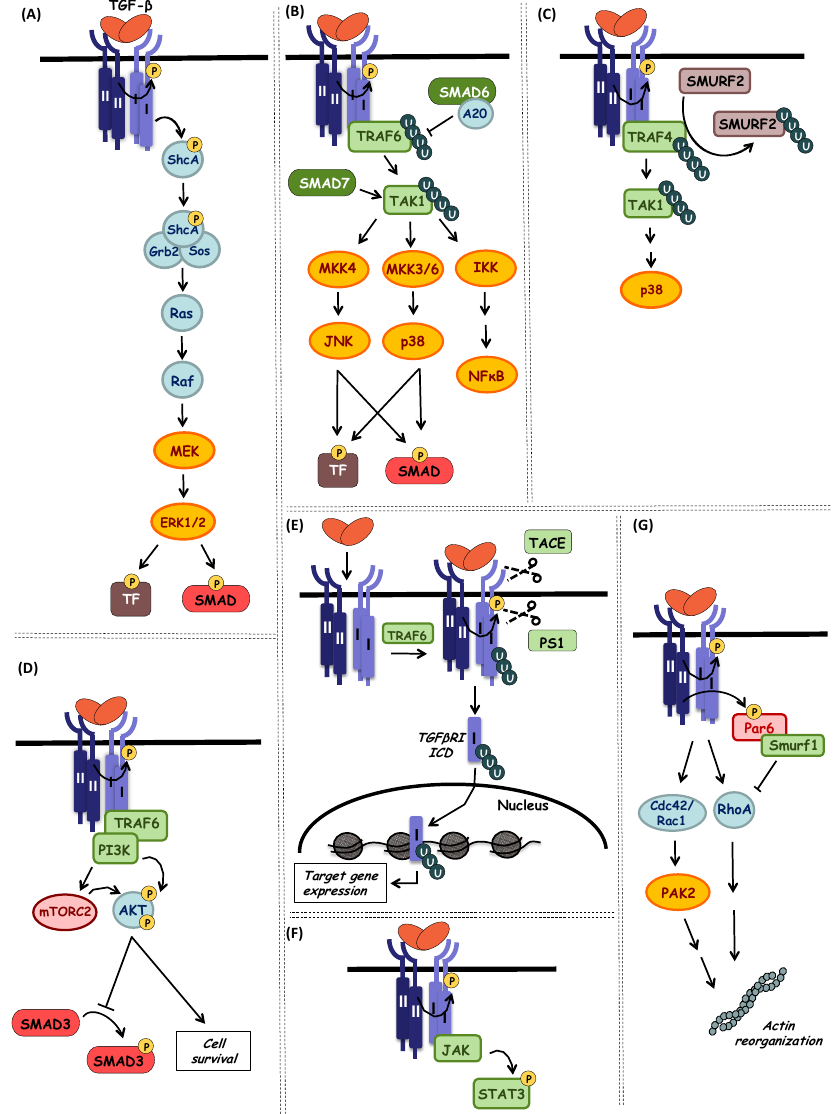
Figure 6. The TGF-β non-SMAD signaling pathways. ( A ) The ERK-MAP kinase pathway. First step Figure 6. The TGF- β non-SMAD signaling pathways. ( A ) The ERK-MAP kinase pathway. First step for the activation of the TGF-β-induced ERK pathway is the phosphorylation of ShcA by the activated for the activation of the TGF- β -induced ERK pathway is the phosphorylation of ShcA by the type I receptor. TGF-β-induced tyrosine phosphorylation of ShcA promotes formation of ShcA/Grb2/Sos complex and Ras activation. This leads to the sequential activation of Raf, MEK1/2 and finally ERK1/2. Activated ERK1/2 phosphorylate transcription factors (TF), thus contributing to TGF-β-induced transcriptional responses. Activated ERK1/2 can also phosphorylate SMADs at the linker region to regulate their activity. ( B ) The p38/JNK and NF-κB pathway (via TAK1). Upon ligand binding, TGF-β receptor complexes interact with TRAF6 promoting its autoubiquitylation. SMAD6 can inhibit TRAF6 ubiquitylation and activation by recruiting the deubiquitylating enzyme A20. TRAF6 activates TAK1 via Lys63-linked polyubiquitylation and activated TAK1 in turn activates through phosphorylation MAP kinase kinases (MKKs) MKK4, MKK3 and MKK6. MKKs activate their downstream kinases JNK and p38, which can then phosphorylate their target transcription factors